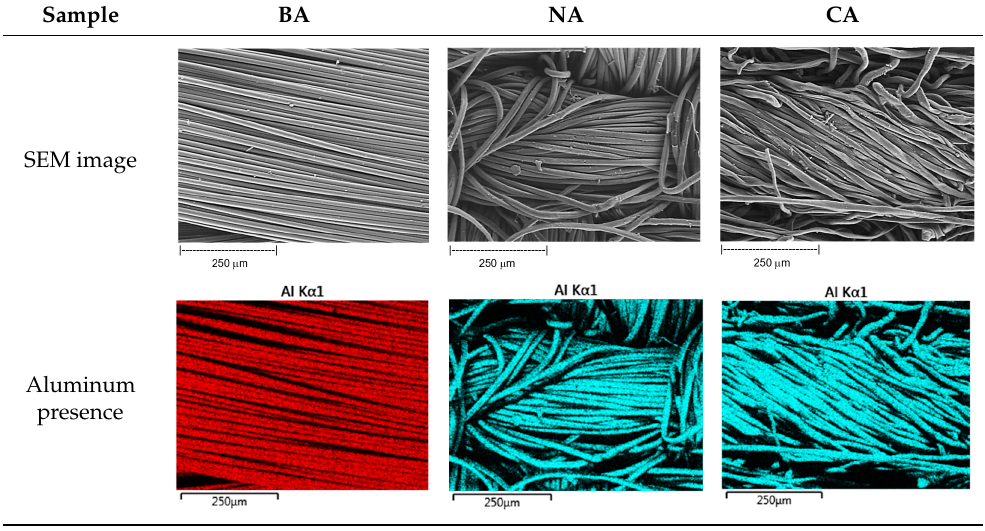
Table 5. Analysis of main chemical constituents present in the aluminum coating. Sample